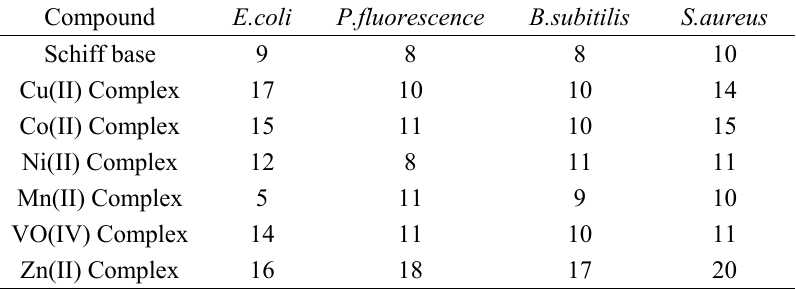
Table 5. Growth Inhibition Zone of Microbes in